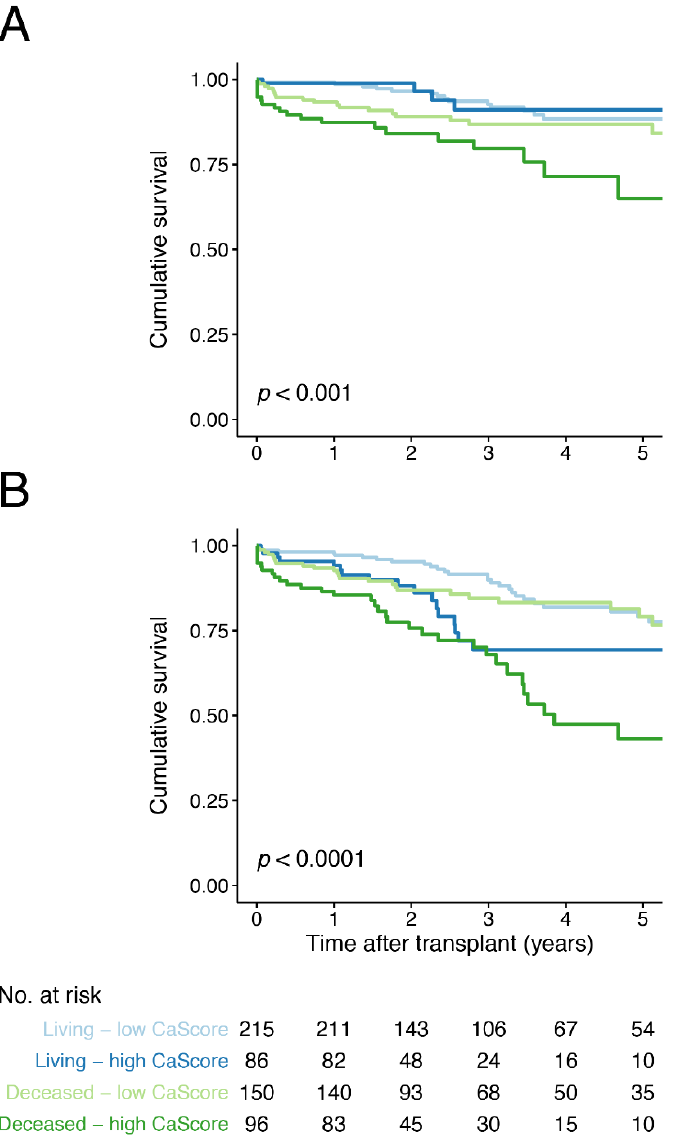
Figure 2. Kaplan–Meier survival curve for ( A ) death-censored and ( B ) overall graft failure free- survival for the low and high aorto-iliac CaScore group, stratified by living and deceased donor kidney transplantation and including a life table applicable for both graphs. Number at risk (No. at risk) provided for all four groups.